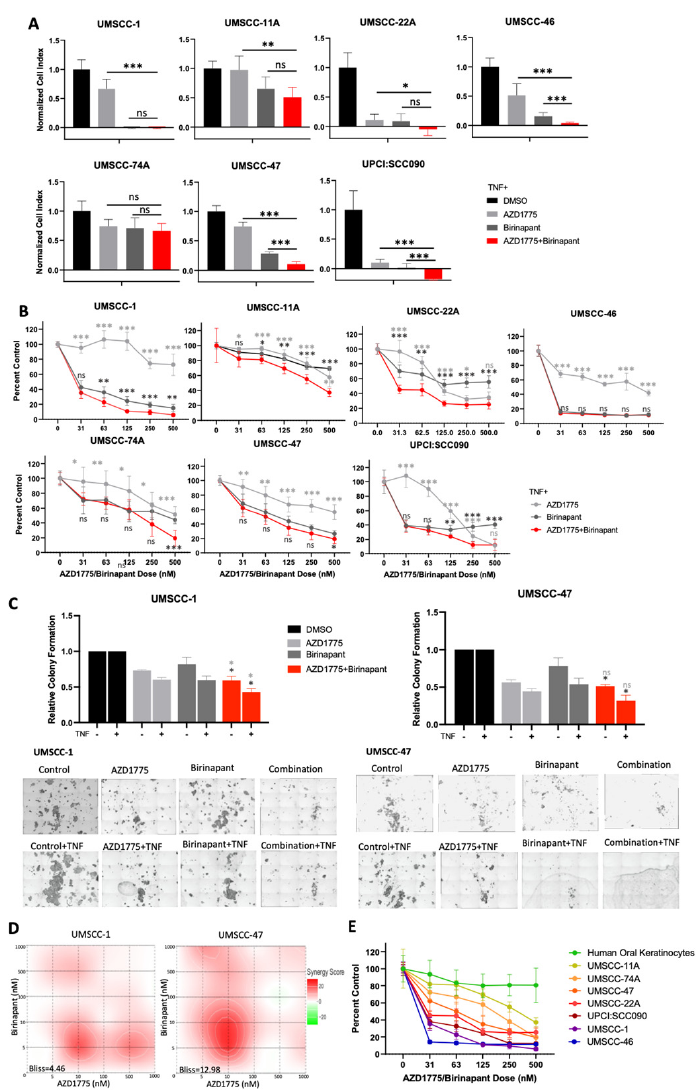
Figure 1. AZD1775 and birinapant combination treatment has therapeutic efficacy in HPV+ and HPV- HNSCC cells in the presence of TNF. ( A ) Impedance assay and ( B ) XTT viability analysis at 72 h after drug treatment, normalized to TNF control. AZD1775 and birinapant 100 nM with the exception of UMSCC-46, which has 2 nM birinapant and 500 nM AZD1775; TNF = 20 ng/mL, n = 6. Single outlier excluded from UMSCC-11A 500 nM AZD1775 group in XTT analysis. ( C ) Colony formation assay in UMSCC-1 and UMSCC-47. AZD1775 = 500 nM, birinapant = 500 nM, TNF = 20 ng/mL. n = 3. ( D ) Bliss Synergy scores according calculated using Synergyfinder software for AZD1775 and birinapant dose responses (0, 5, 10, 100, 500, 1000 nM) and TNF = 20 ng/mL. ( E ) XTT viability analysis with HOK cells compared to a panel of HNSCC cell lines; TNF = 20 ng/mL, n = 6. ns = not significant; * p < 0.05; ** p < 0.01; *** p < 0.001.